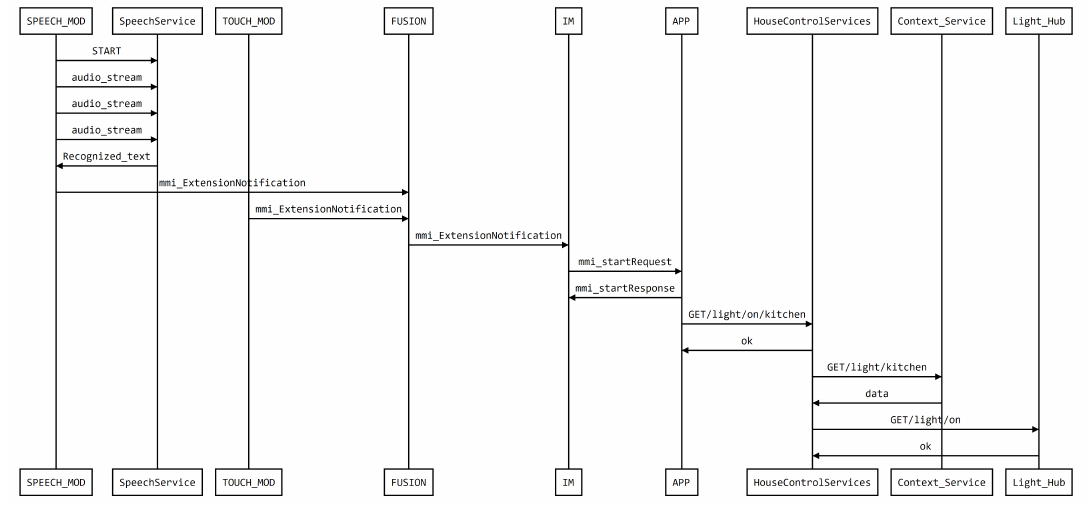
Figure 14. Sequence diagram of the communication between the different components of the framework, while turning on the lights, in the living room, when the user is located in another